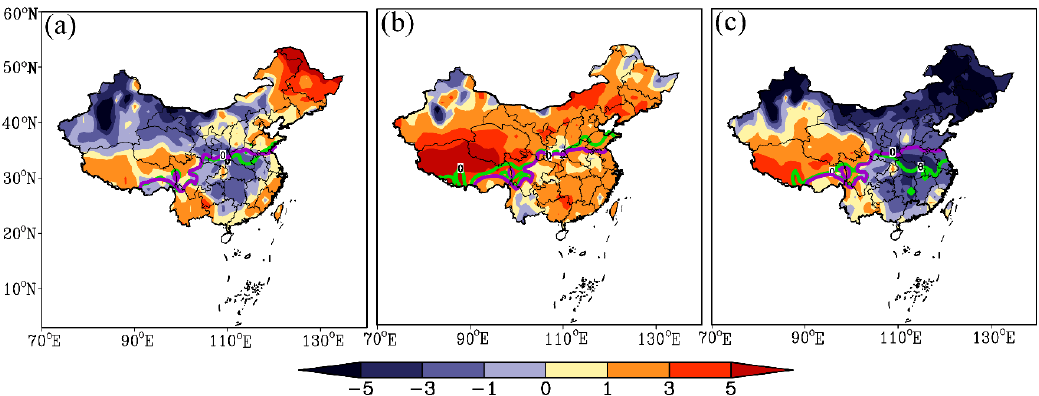
Figure 2. The maps of the near-surface air temperature anomalies (colored shading; units: °C) over China in early ( a ), mid ( b ), late ( c ) January 2018, relative to 1959–2018. The thick purple lines are 0 °C in climatology (for the period 1959–2018) and the thick green lines are 0 °C in 2018.